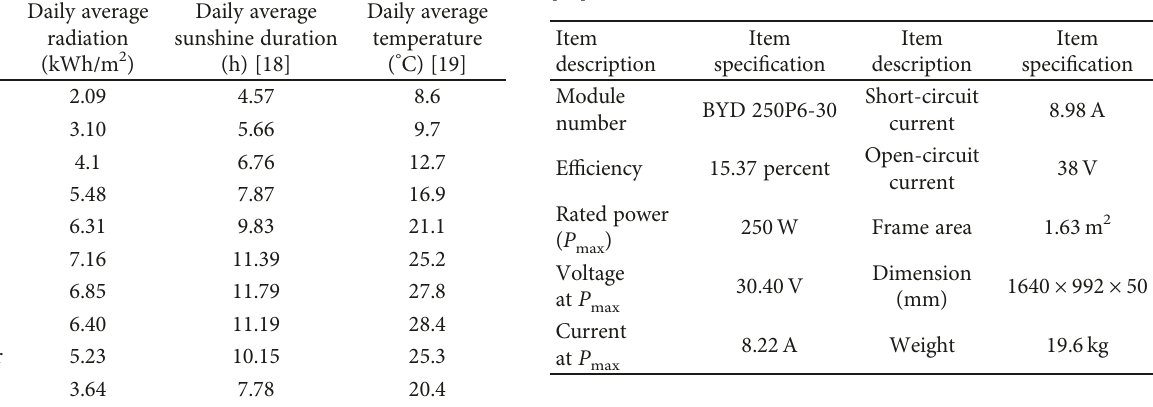
Table 4: Technical speci fi cations of a photovoltaic module used